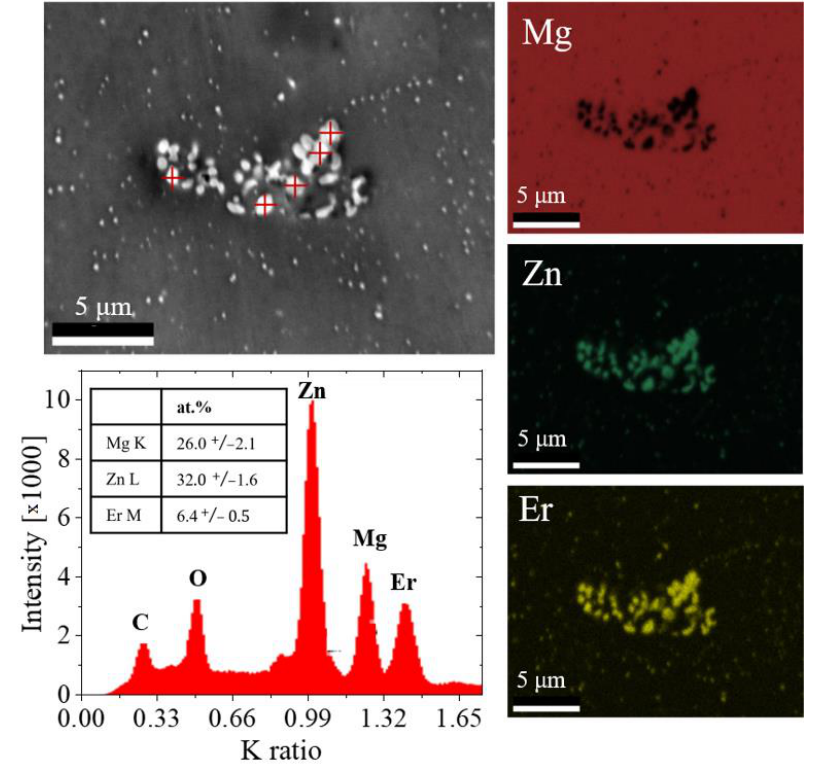
Figure 6. EDS analysis of the Er-containing precipitates observed in the Mg-1%Er-1%Zn alloy.